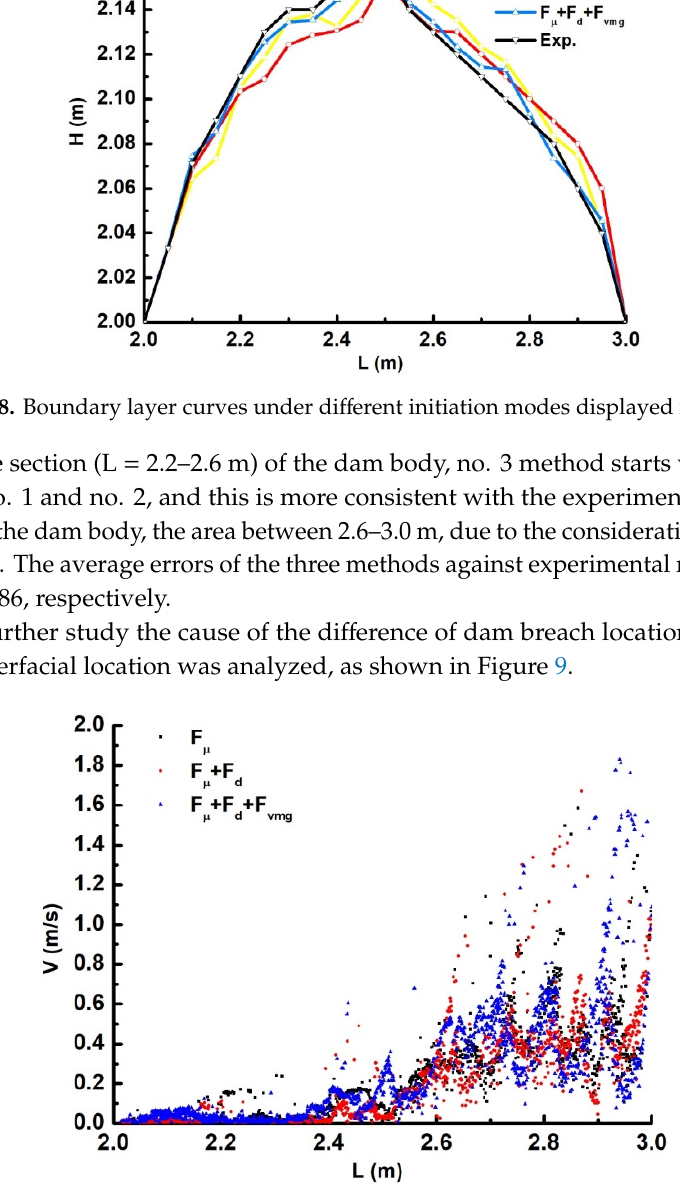
Figure 8. Boundary layer curves under different initiation modes displayed in Table 1.